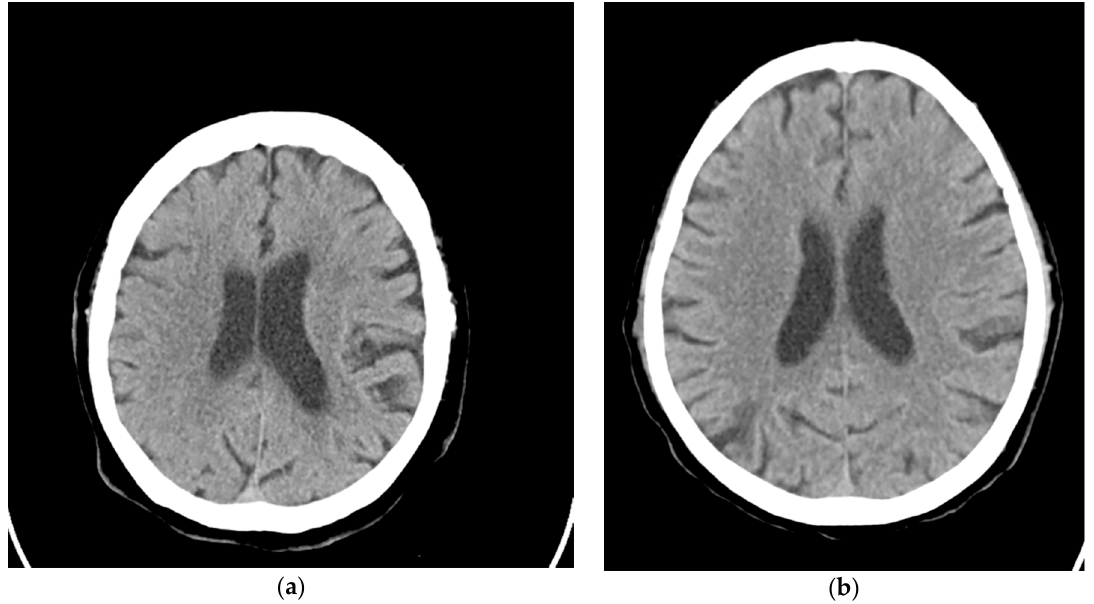
Figure 5. Two hyperacute stroke cases correctly classified by Ranklet features but misclassified by gray level co-occurrence matrix (GLCM) features. ( a ) A case of right middle cerebral artery (MCA) territory infarction with a stroke likelihood of 80%. ( b ) Another case of right MCA territory infarction with a stroke likelihood of 87%.